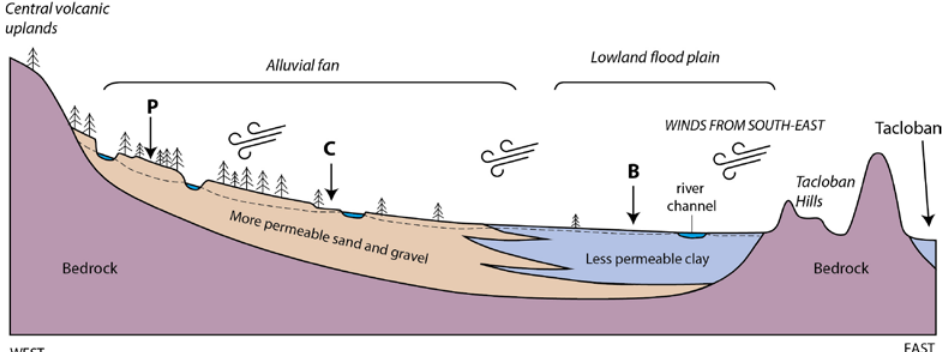
Figure 3. Vertically exaggerated schematic cross section to show the geographical context and simplified geology of the communities investigated in this study. P: Plaridel, C: Calabnian, B: Badiangay. The dashed line represents groundwater level.